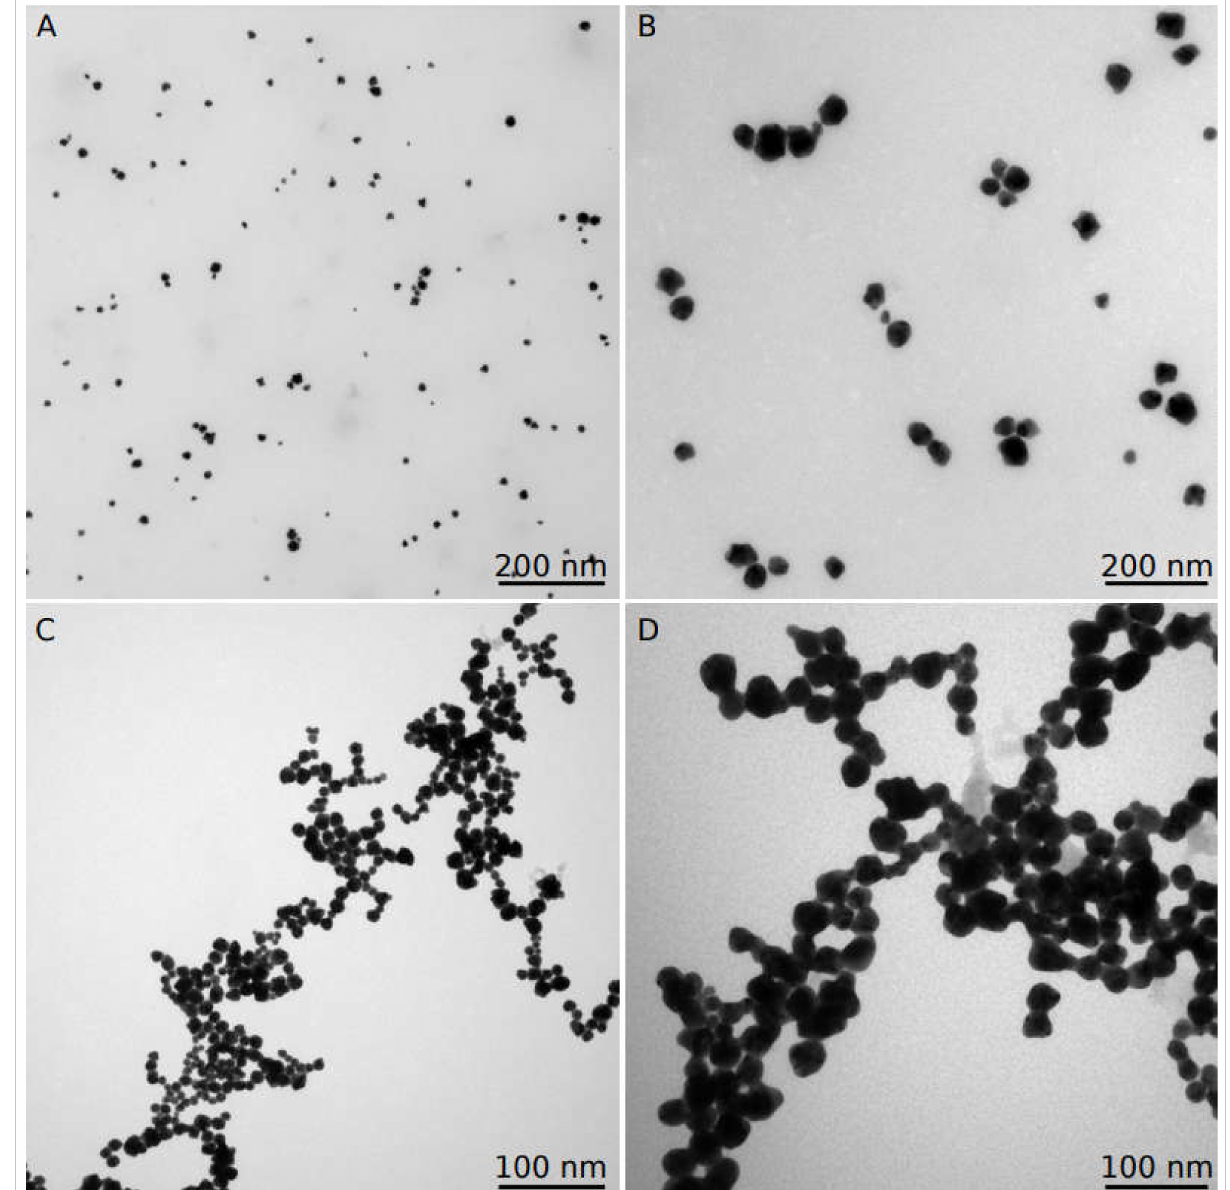
Figure 10. TEM Images obtained from different samples: ( A , B ) washed sample at pH 6; ( C , D ) washed sample at pH 10. Scale bars for ( A , C ) = 200 nm; ( B , D ) = 100